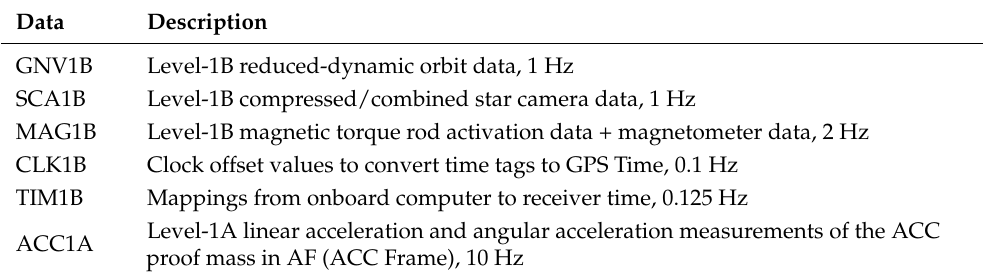
Table 5. GRACE-FO data product for CM-offset